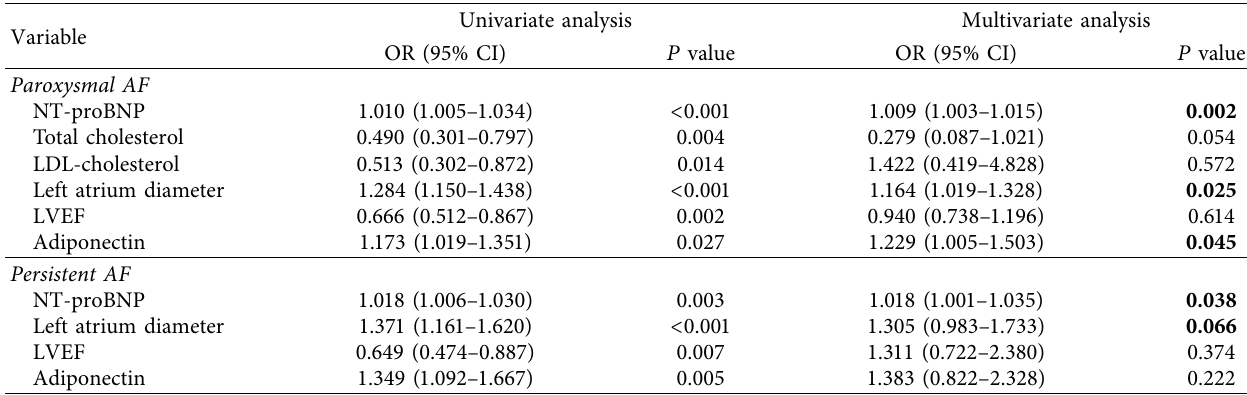
Table 6: Univariate and multivariate logistic regression analysis for the independent predictors of AF stratified by type of AF. Variable